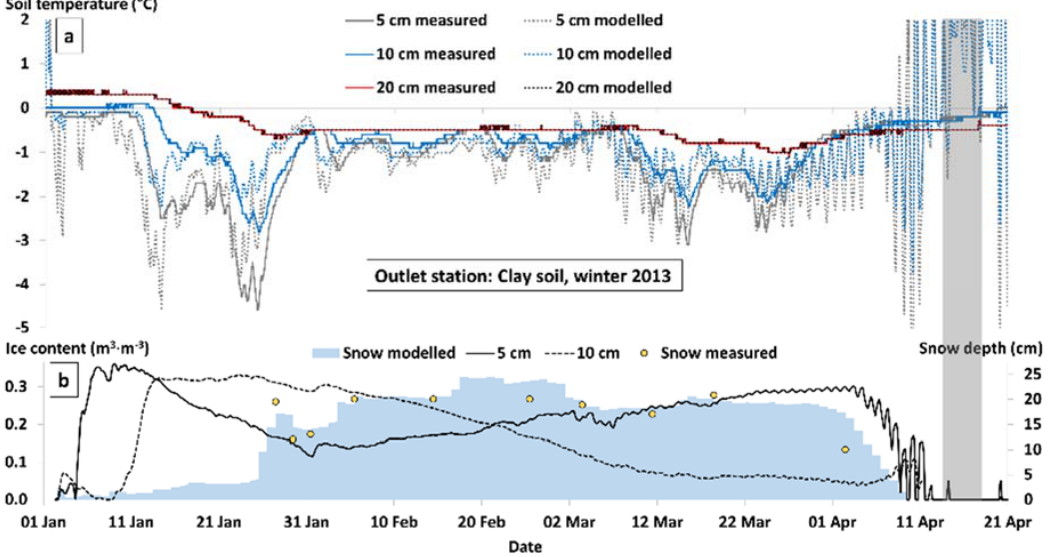
Figure 6. Diagram of ( a ) modelled and measured soil temperature at three depths (5, 10 and 20 cm) in the clay soil (at outlet station) during winter 2013; diagram of ( b ) measured and modelled snow depths at the outlet station and modelled ice content at the three depths in the clay soil (was zero at 20 cm). The duration of the rain event of interest is marked with a grey band.